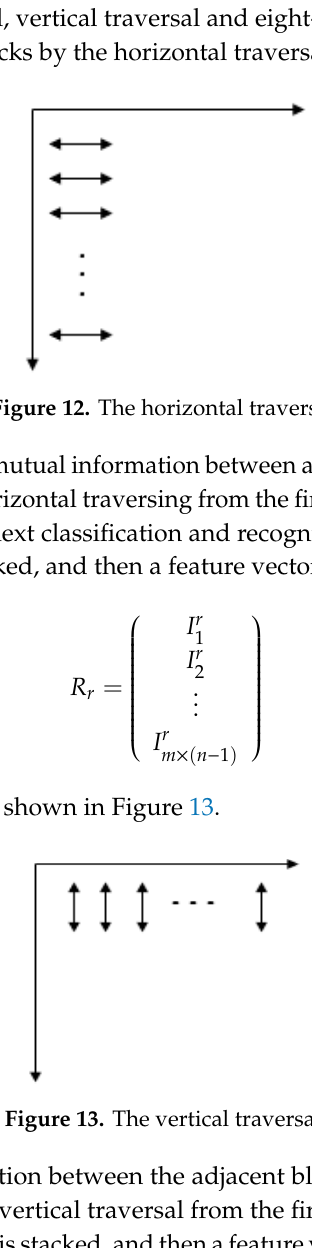
Figure 13. The vertical traversal.